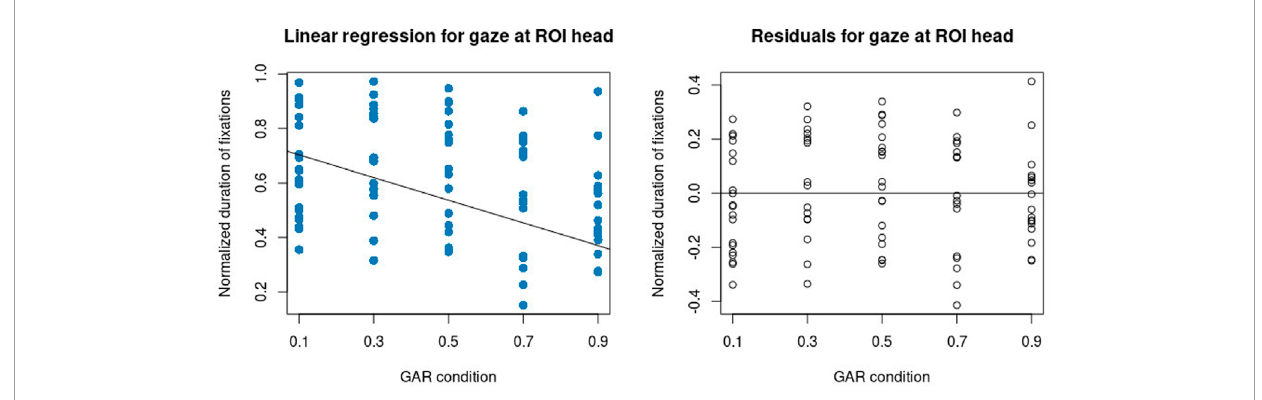
FIGURE 5 Left: linear regression model between GAR and fixation duration at ROI head. Right: the residuals of the linear regression.